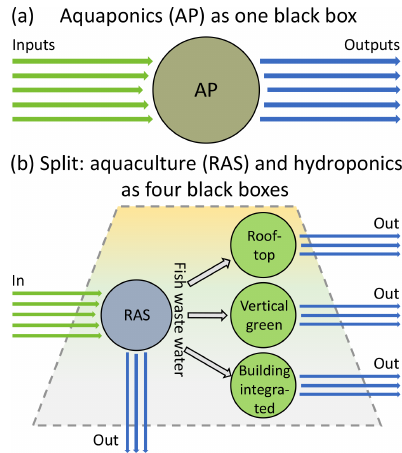
Figure 1. Black boxes: two use cases with (a) one respectively (b) four CE